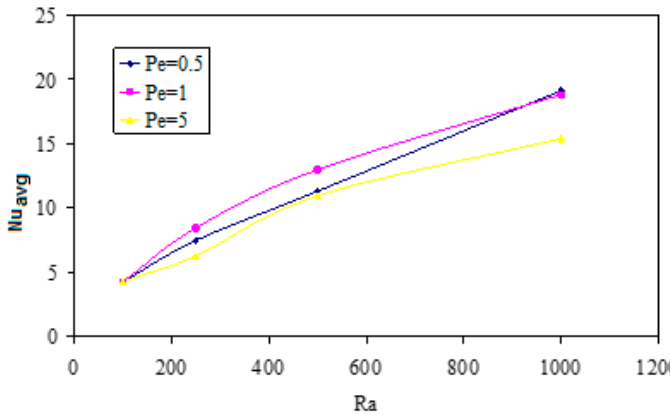
Figure 8. Variation of average Nusselt number with Rayleigh number ( c = 0.33).